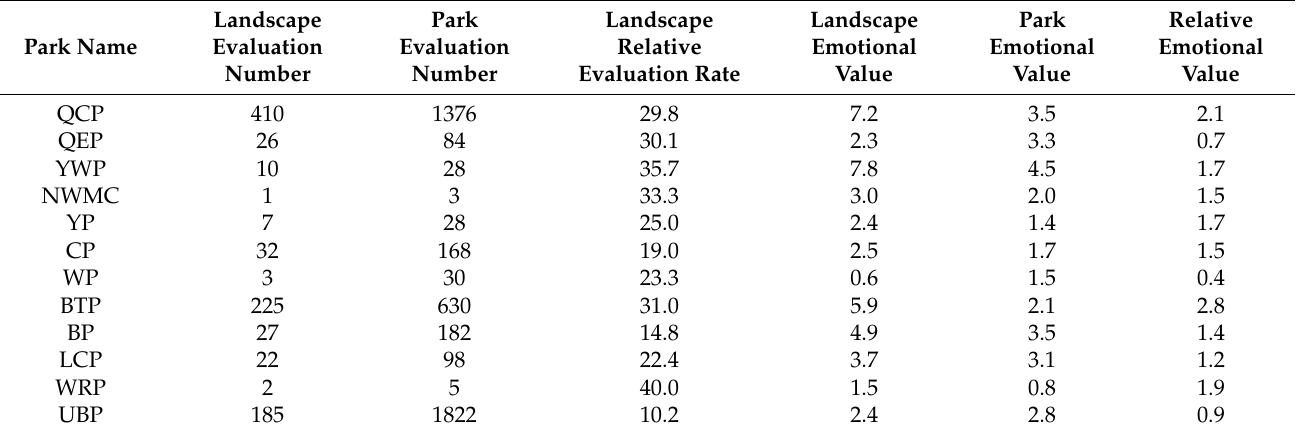
Table 5. Landscape visitor evaluation and emotional response to waterfront